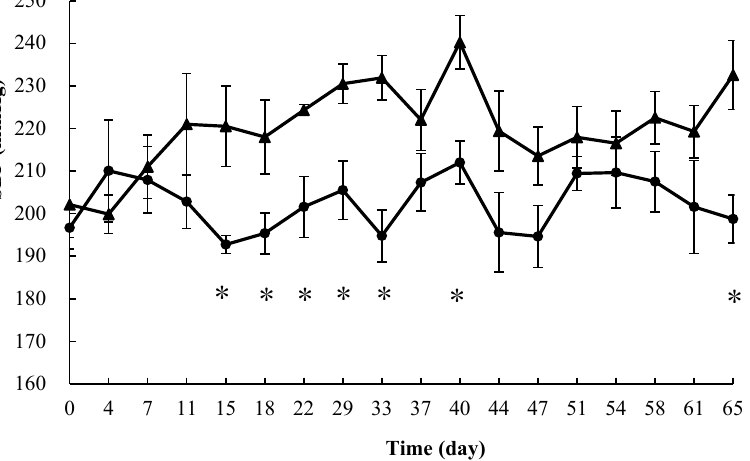
Figure 3. Systolic blood pressure of spontaneously hypertensive rats (SBP) treated with different products: Control ( ▲ ) and Fermented ( ● ), p < 0.05 (*), The data represented the mean values ± standard error ( n = 6).